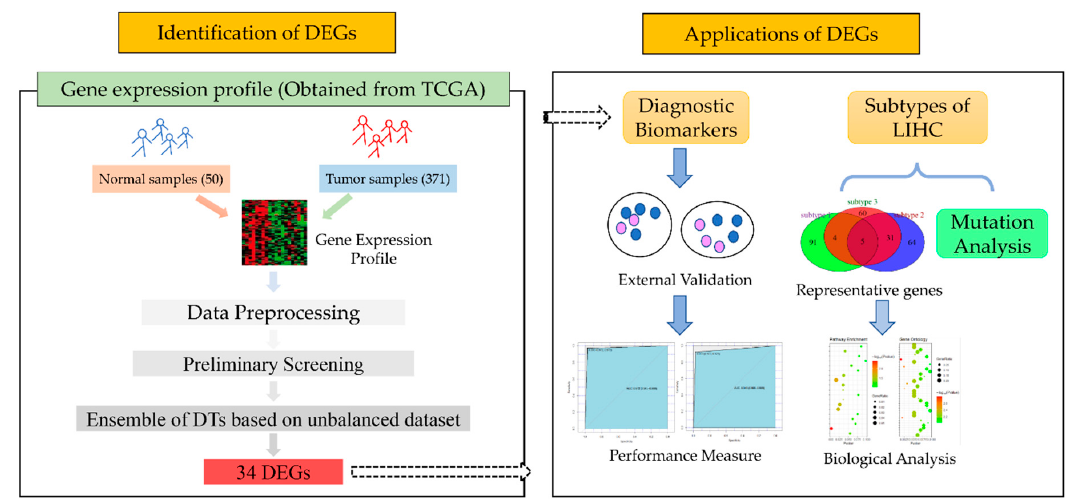
Figure 1. The flowchart of our main work. The process to obtain differentially expressed genes (DEGs) between tumors and normal samples is in the left panel, and the two main applications of our DEGs are in the right panel. Liver hepatocellular carcinoma (LIHC), the Cancer Genome Atlas (TCGA), and decision trees (DTs).